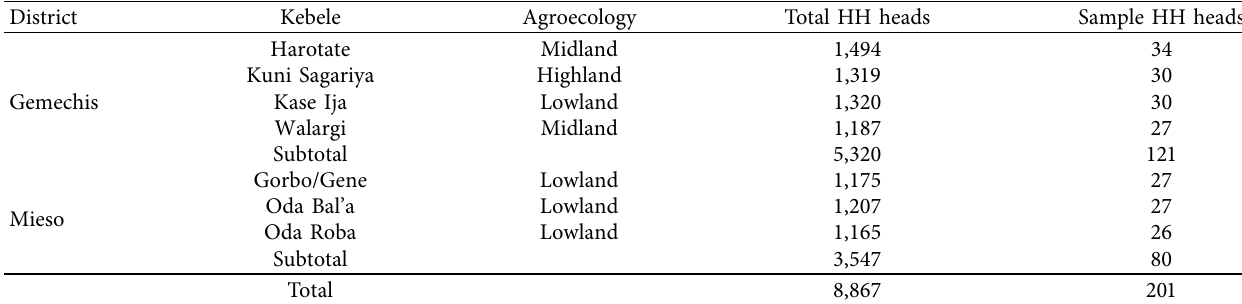
Figure 1: Location map of the study areas. Source: West Hararghe Zone Agriculture Natural Resource Office (2019). Table 1: Sample kebeles, agroecologies, total households, and distribution of sample